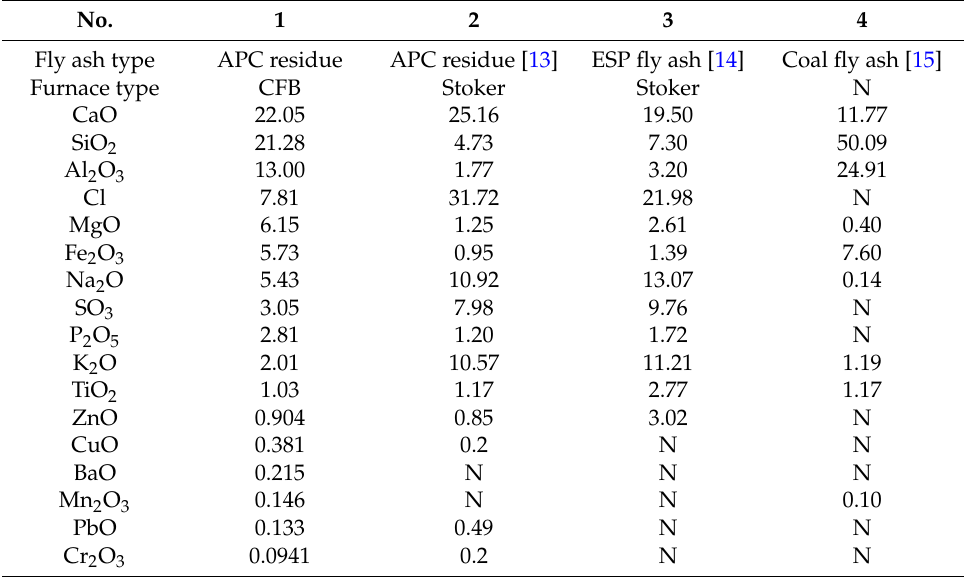
Table 1. The comparison of main elements in different fly